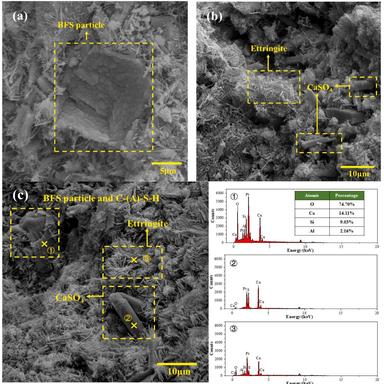
SEM-EDS of HPFA0 specimen. (a)3-day age, (b)7-day age, (c)28-day age.